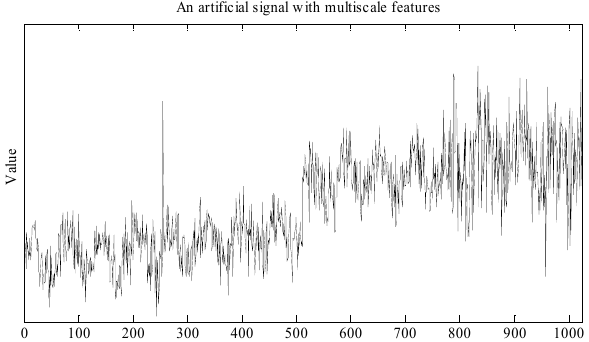
Figure 2. An artificial signal containing multiscale features: a linear trend, a sinusoid, a step perturbation, a spike (deterministic features with different frequency localization characteristics) and white noise (a stochastic feature whose energy is uniformly distributed in the time/frequency plane).